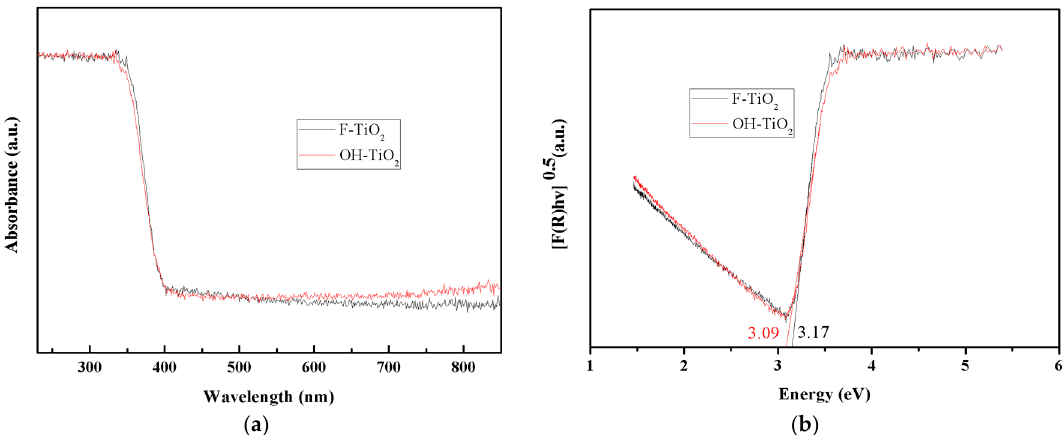
Figure 4. ( a ) UV ‐ Vis diffuse reflectance spectra and ( b ) bandgap of as ‐ prepared F ‐ TiO 2 and OH ‐ TiO 2 samples.